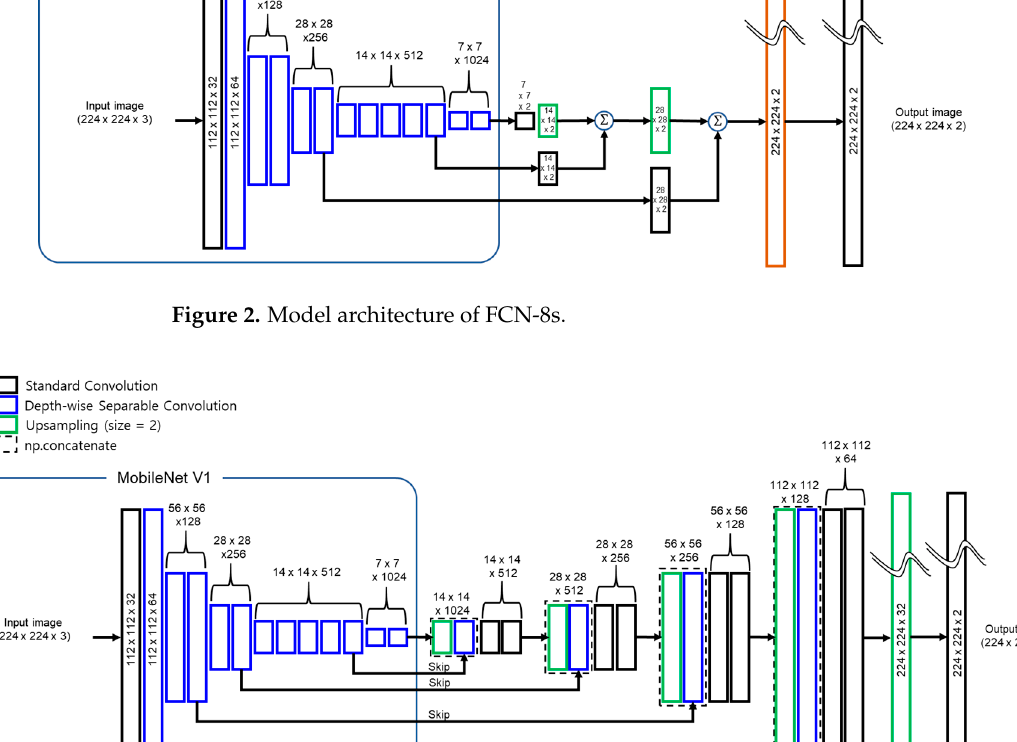
Figure 4. Model architecture of DeepLabV3. Figure 5. Model architecture of DeepLabV3Plus.